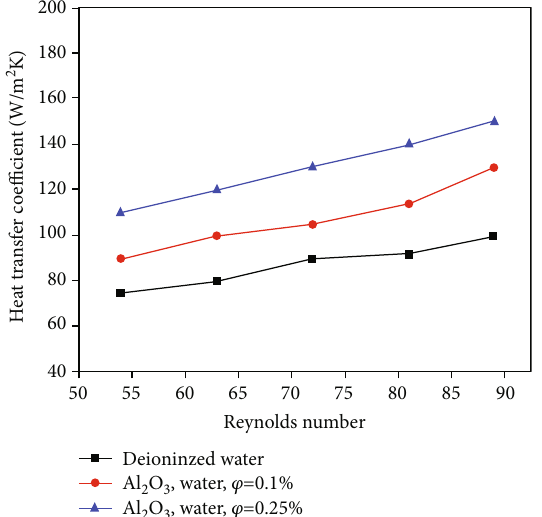
Figure 9: Heat transfer coe ffi cient vs. Reynolds heat input number of